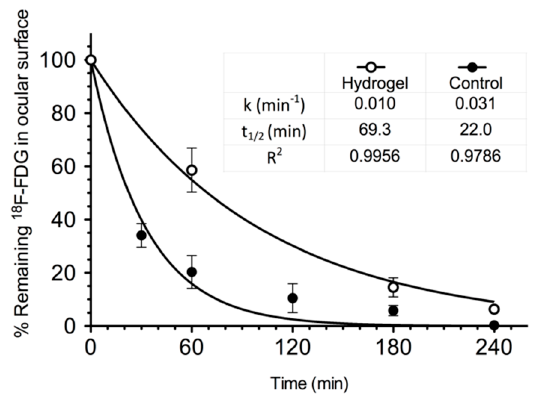
Figure 2. PET (left), CT (right), and PET/CT fused image. The biopermanence evaluation of the hydrogel labeled with 18F-fluorodeoxyglucose (FDG) (right eye) in rats compared to a saline solution containing 18F-FDG as control formulation (left eye). Reproduced from [33], which is licensed under